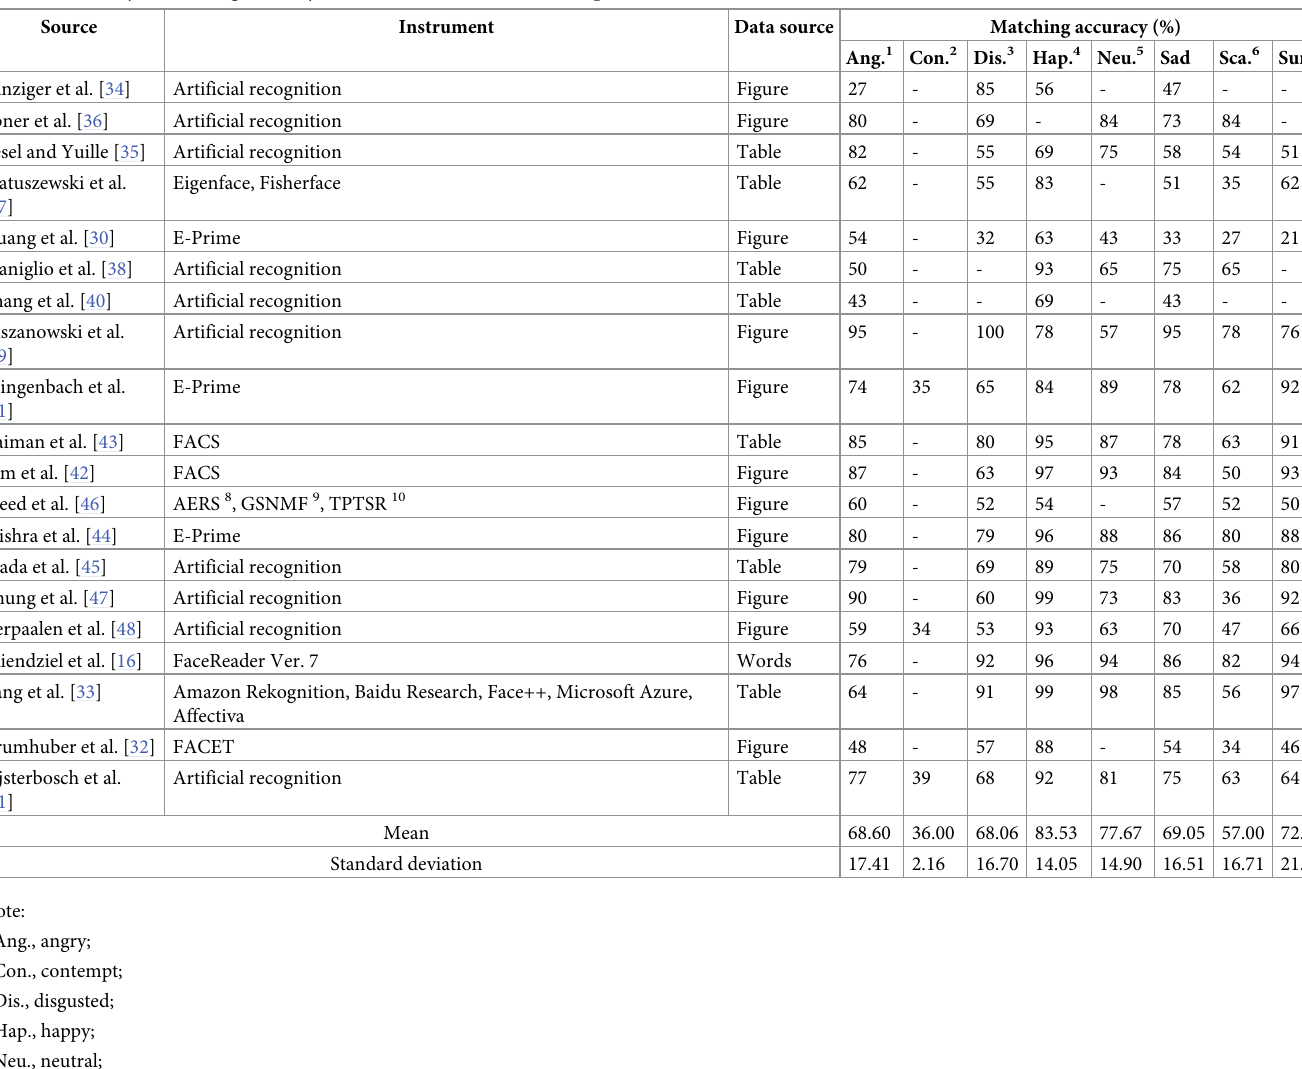
Table 1. Summary of matching accuracy for validation studies on facial